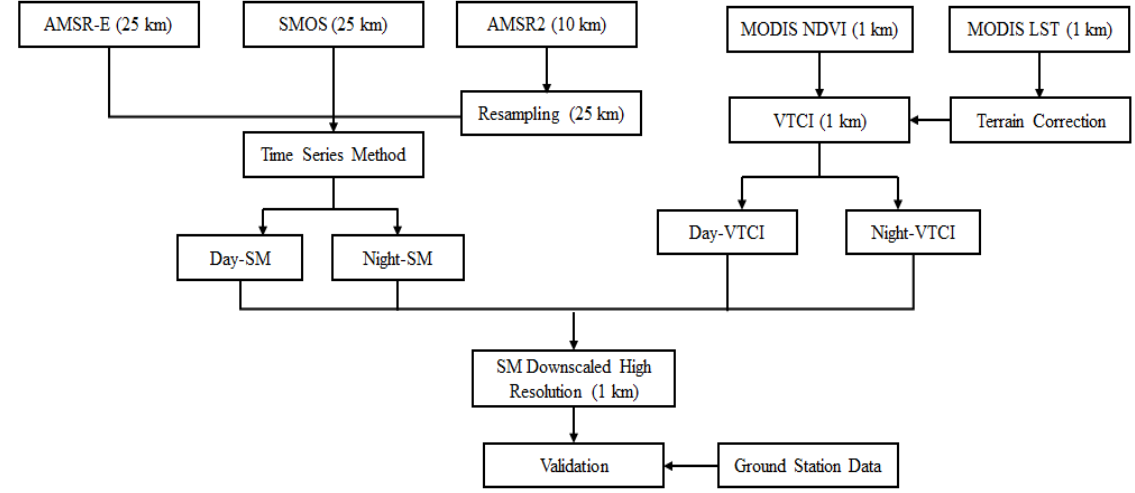
Figure 3. Overall workflow for the soil moisture downscaling mode.